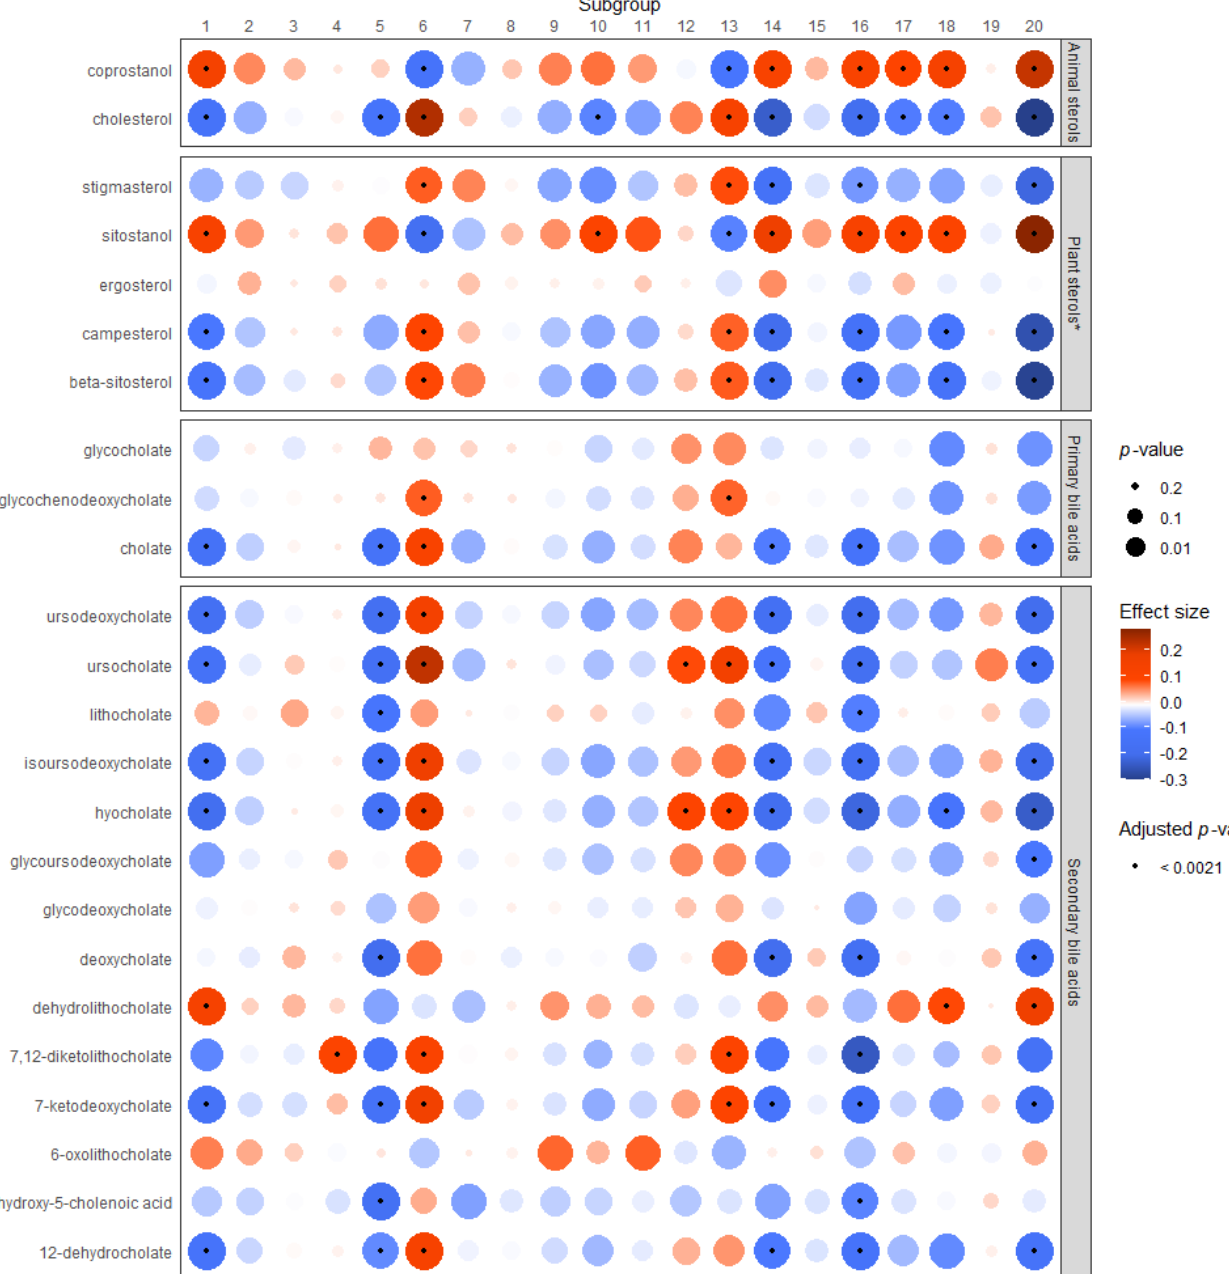
Figure 2. Associations between microbial subgroups and fecal bile acids or sterols. * The linear trend is shown here. However, these models indicate the presence of a non-linear relationship, which cannot be represented in the heat map. Supplementary Figures S2–S6 depict the non-linear relationship for each plant sterol and subgroup in comparison to the linear trend shown here.